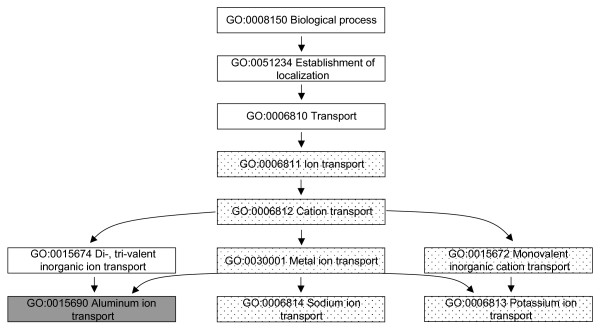
Ion transport related differentially regulated processes. The dotted boxes represent GO terms that were up-regulated in both the normal and the tumour tissues of the exposed patients in comparison to the non-exposed using both the t-test and fold change based ranking. The grey boxes represent GO terms that were up-regulated using at least one of the tests.